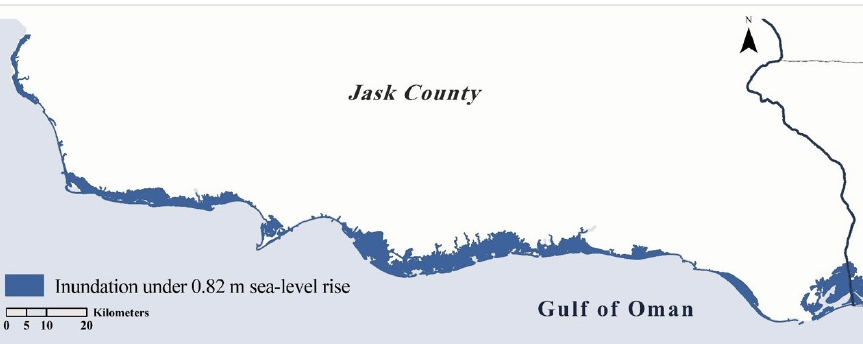
Figure 4. The extent of permanent inundation under 0.82 m of sea-level rise by 2100.